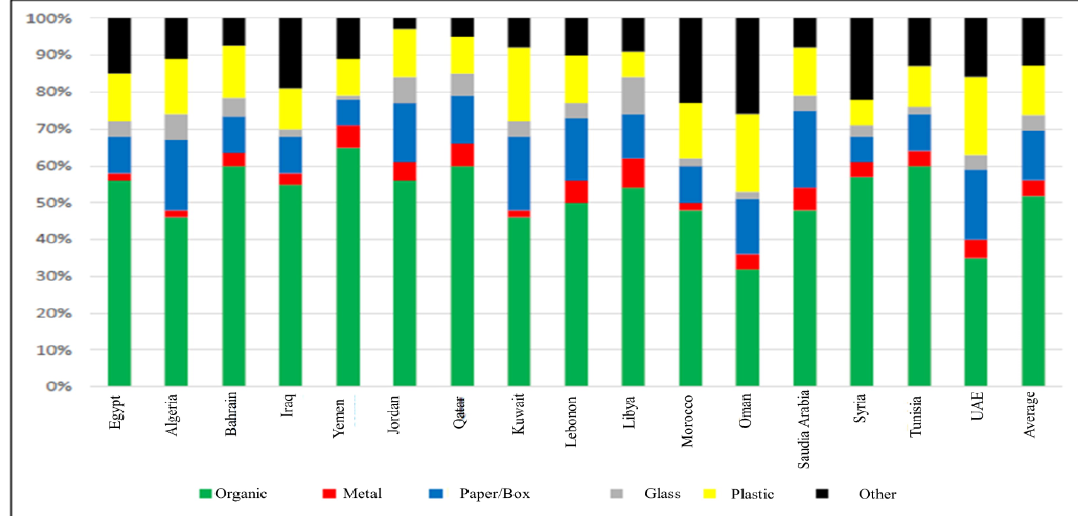
Figure 2. Waste composition in the Middle East and North Africa (MENA) region [9].